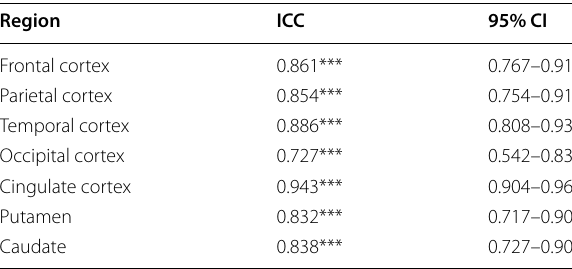
Table 4 Intraclass correlation for rCBF whole sample, n